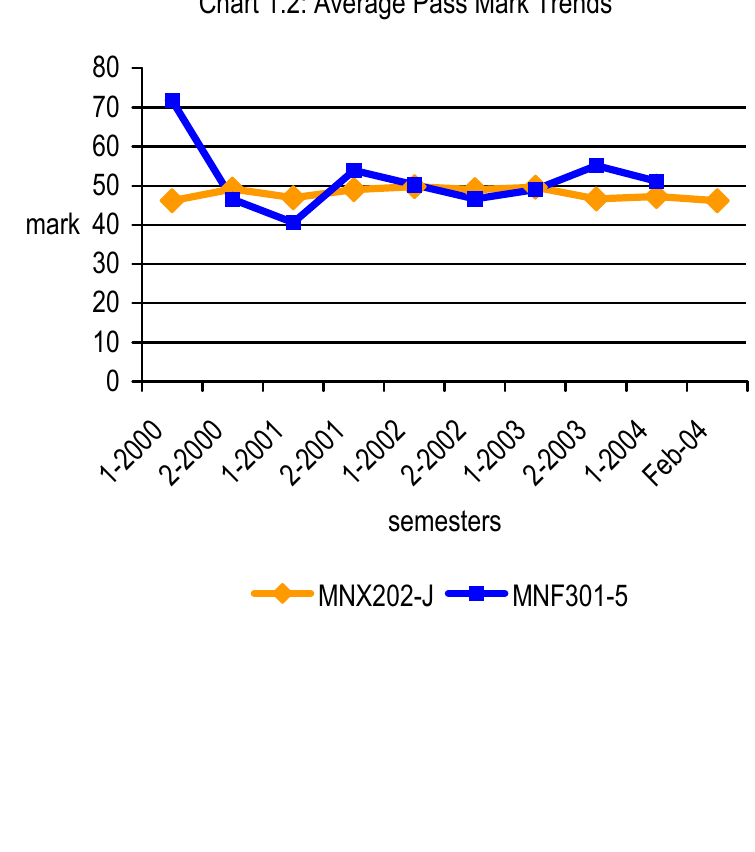
Table 1.2b indicates final examination marks from 2000 to 2004 for MNF301-5 students. Prior to 2003 average examination marks have ranged between 40,5% and 71,7% (latter mark a result of examination paper being 100% MCQs). Since the introduction of a compulsory assignment examination averages have ranged between 49,0% and 55,1%. Chart 1.2: Average Pass Mark